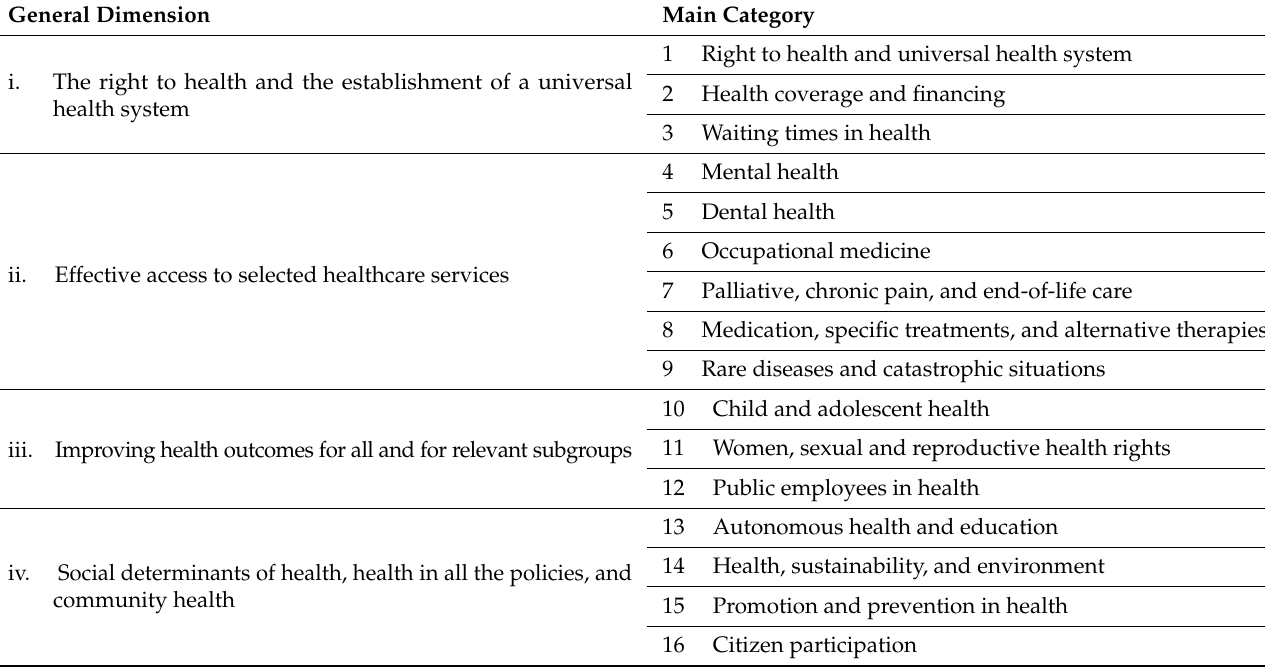
Table 1. Classification of the popular initiatives by dimensions and categories of analysis. Health- related civil proposals for the new constitution in Chile,